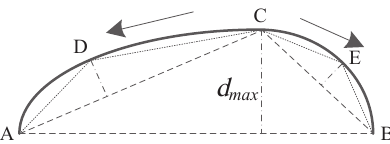
Figure 6. The basic principle of PSM polygon